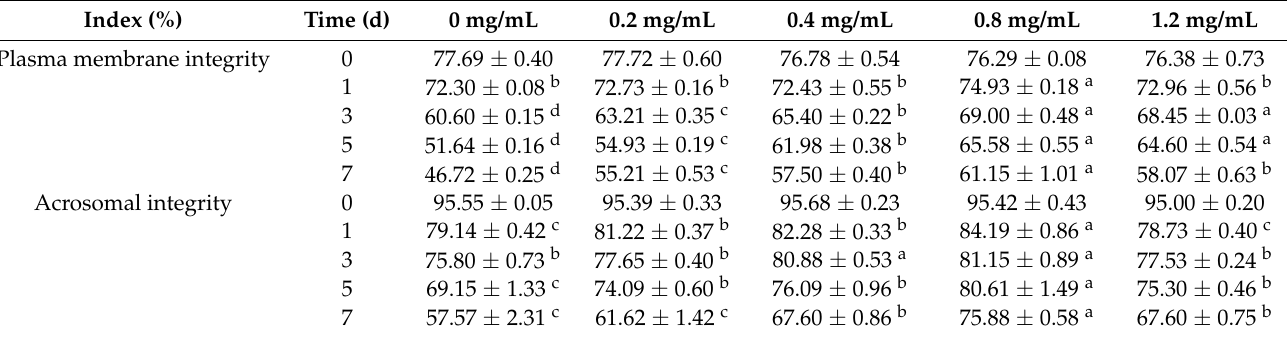
Table 2. Effects of CGA with different concentrations on plasma membrane and acrosome integrity of chilled ram sperm.